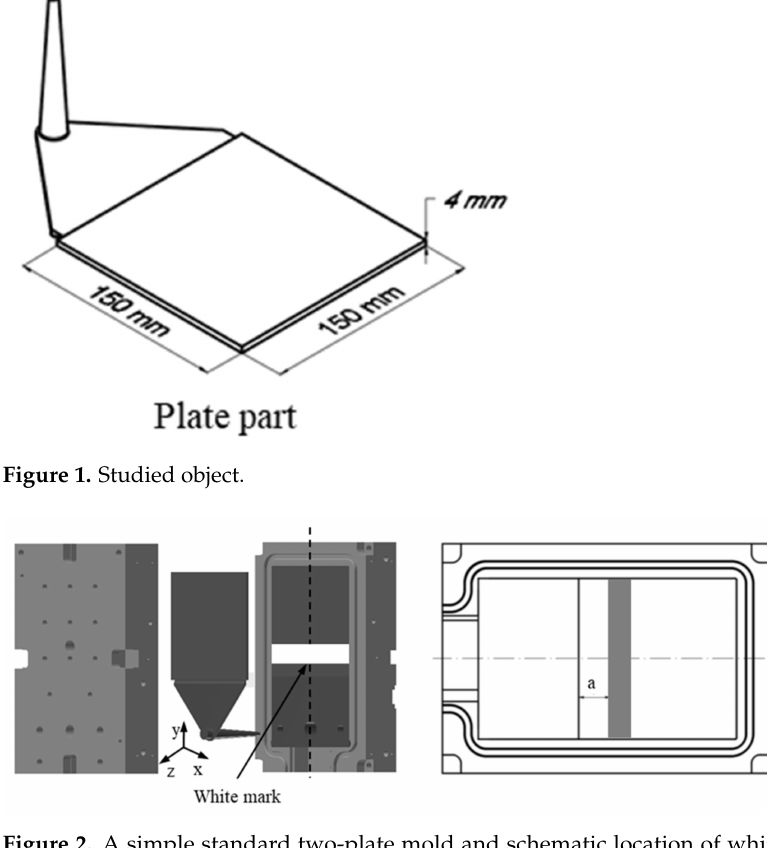
Figure 2. A simple standard two-plate mold and schematic location of white marks on the mold wall